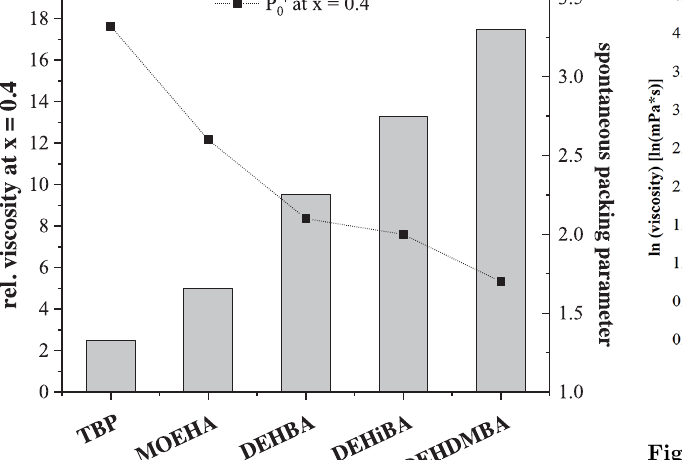
Fig. 5. Correlation between the spontaneous packing para- meters estimated from geometry and the observed viscosity (in grey, cf. Fig. 4). For illustration, the viscosity of TBP, MOEHA, DEHBA, DEHiBA and DEHDMBA is shown at a uranyl content of x =[uranyl]/[Ex] = 0.4. The estimation of the spontaneous packing parameter is explained in the supplementary informa- tion.